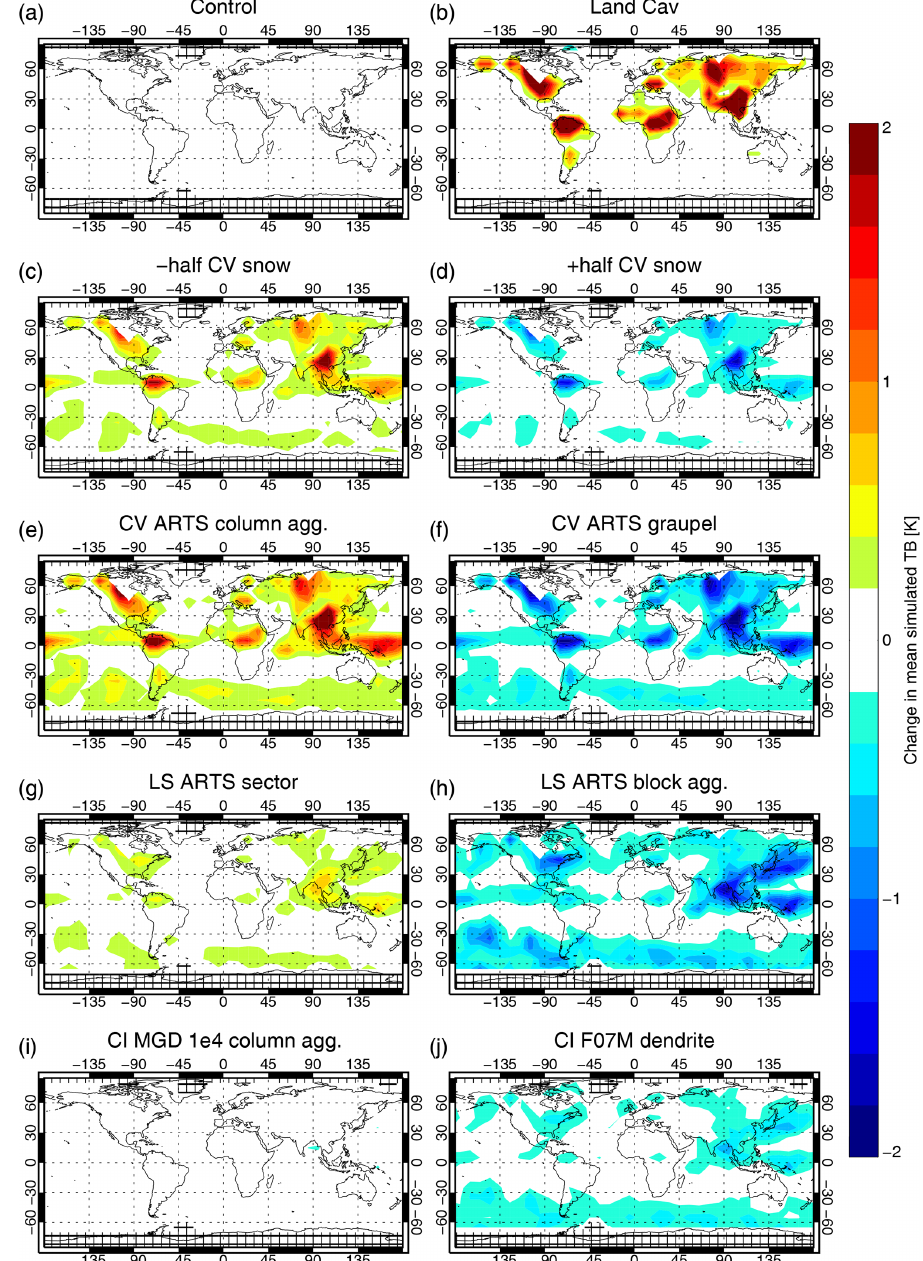
Figure 2. Mean change in simulated brightness temperatures when using some of the options from Table 2, compared to the control. Statistics are based on a 10d period and shown for SSMIS channel 150h, which is generally the channel with the largest impact from changes in the physical assumptions for frozen